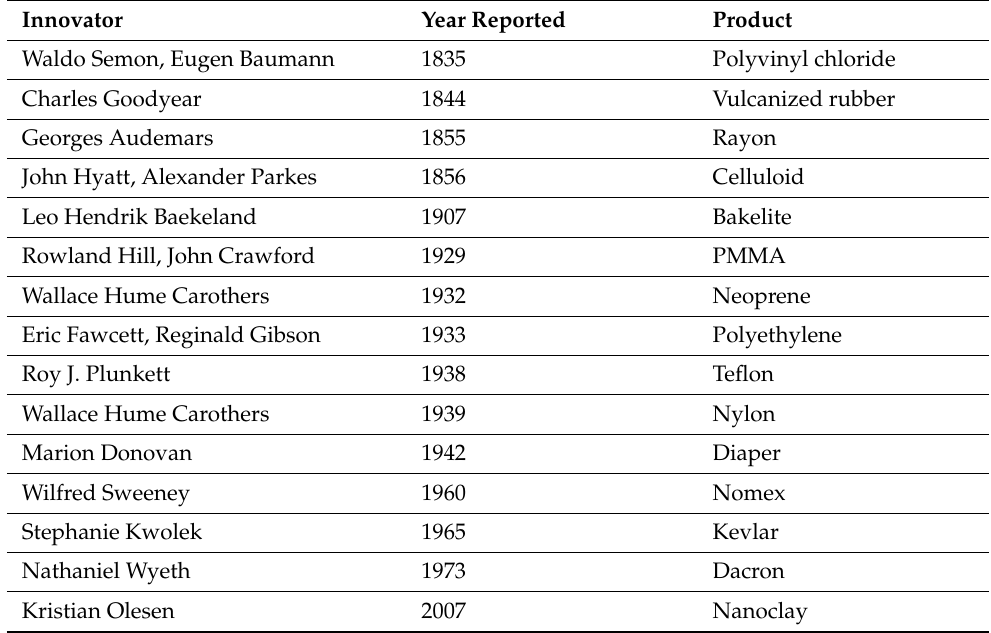
Table 2. List of imperative inventions in polymers along with their year of reporting.